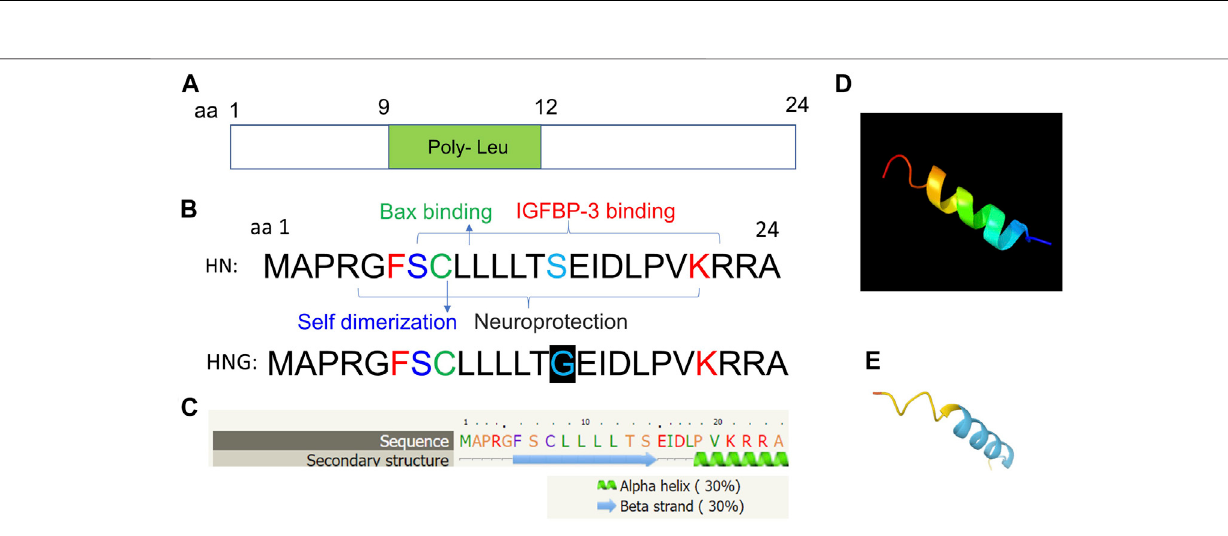
Frontiers in Cell and Developmental Biology |